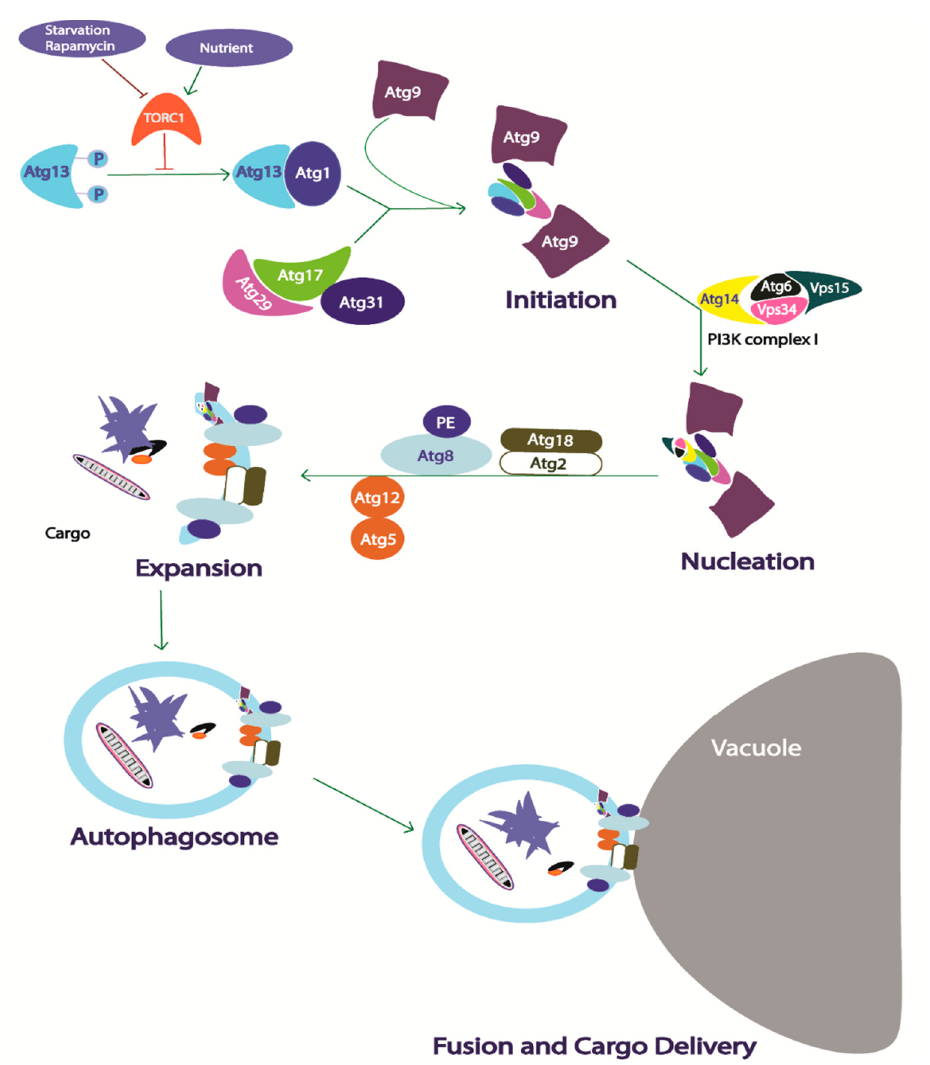
Figure 5. Schematic diagram of autophagosome formation and delivery of embedded cargo to the vacuole. Arrow, activates; Blunt arrow, blocks / inhibits; Atg, autophagy related; PI3K, phosphatidyl inositol 3 kinase; PE, phosphatidylethanolamine. Autophagosome formation is completed in four steps starting from the activation of Atg13 and formation of Atg1 kinase complex at the pre-phagosome assembly site. The second step involves the initiation of the phagophore formation by recruiting Atg9 protein. The phagophore nucleation occurs following Atg9 conjugation, where complexation with phosphatidyl inositol 3 kinase complex I occurs. The expansion of the double walled phagophore occurs embedding the cytosolic cargo that will ultimately give rise to autophagosome. The mature autophagosome then delivers the embedded cargo to the vacuole for